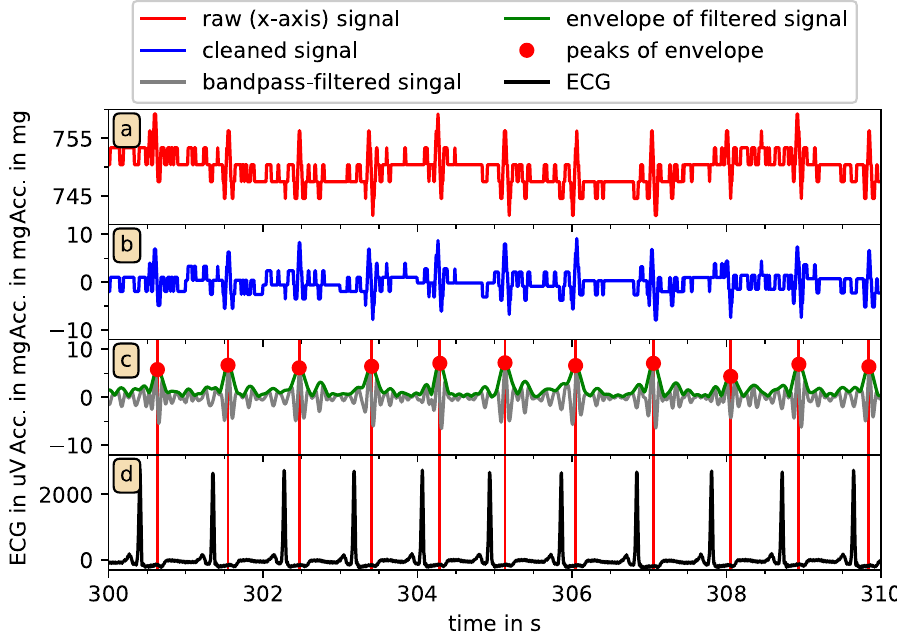
Fig 4. Reconstruction of pulse waves from acceleration data. In (a) and (b) the raw (red) and cleaned (blue) x -axis acceleration data from a typical recording is shown for ten seconds. Panel (c) shows the signal after the 5-14 Hz FFT- bandpass-filtering (gray), the absolute of the Hilbert transform (green), and the results of the peak detection (red dots). In (d) the ECG-signal (black) is presented and compared to the pulse wave peak (red vertical lines). Please also note the impact of respiration in panel (a) leading to a modulation of the acceleration data with a period of about 4 s. These modulations are removed in panel (b) by subtracting one-second averages.